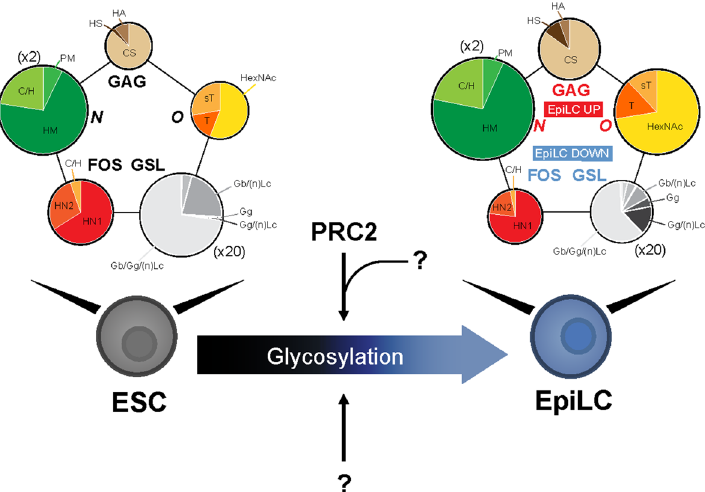
Figure 8. Schematic model of glycosylation dynamics and regulatory network during the ESC (naïve) to EpiLC (primed) transition. The overall glycosylation composition changes dramatically during the naïve to primed transition. PRC2 is a key component of the developmentally regulated network orchestrating glycosylation dynamics. The size of each pie chart reflects the absolute mean quantity of glycans (pmol/100 μg of protein). N -linked and GSL pie charts size is scaled 2 and 20 times,